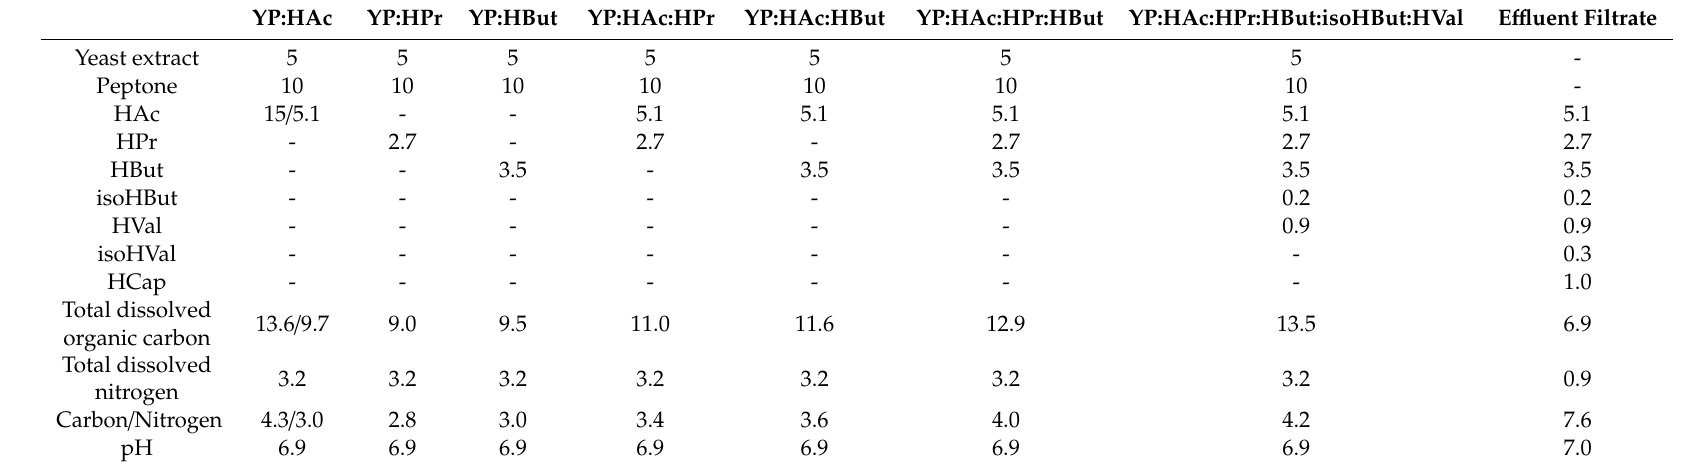
Table 1. Media composition (g L − 1 ) and